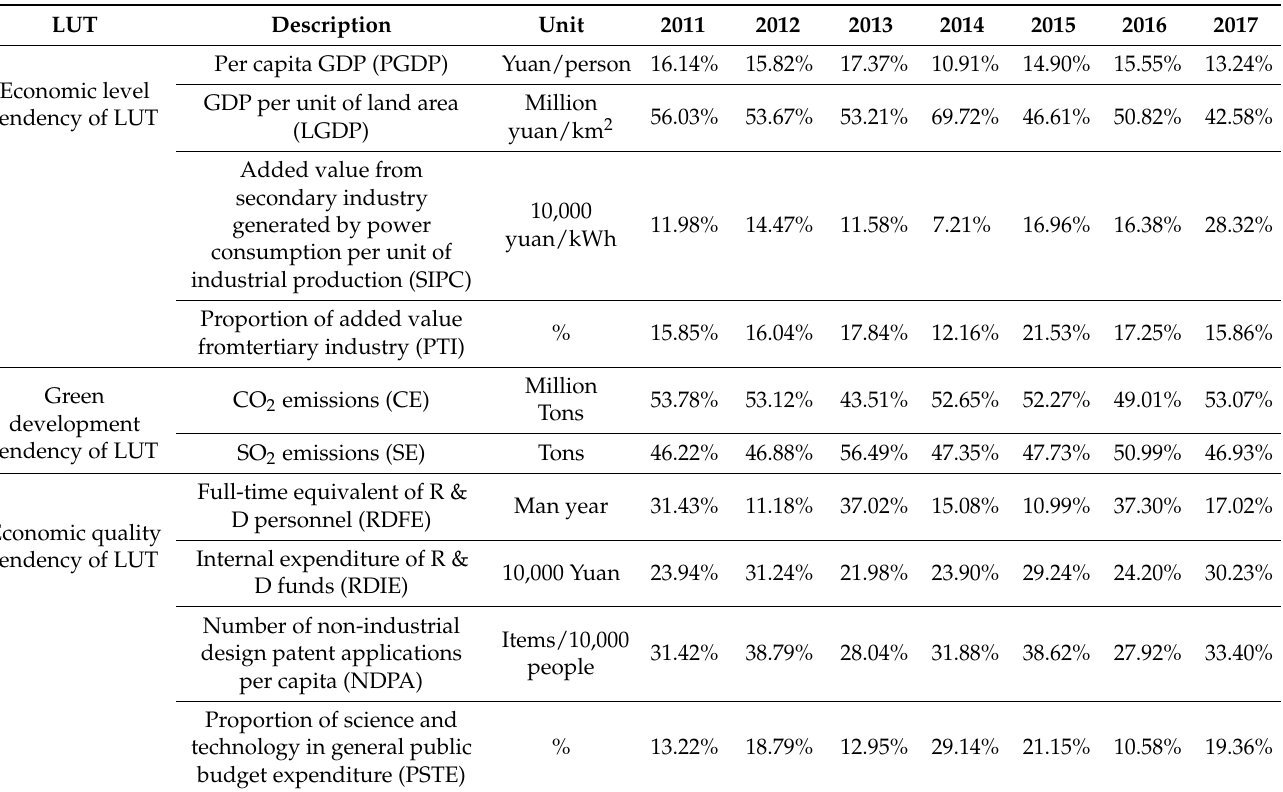
Table 1. Indicators evaluation system of LUTs and weight distribution over the